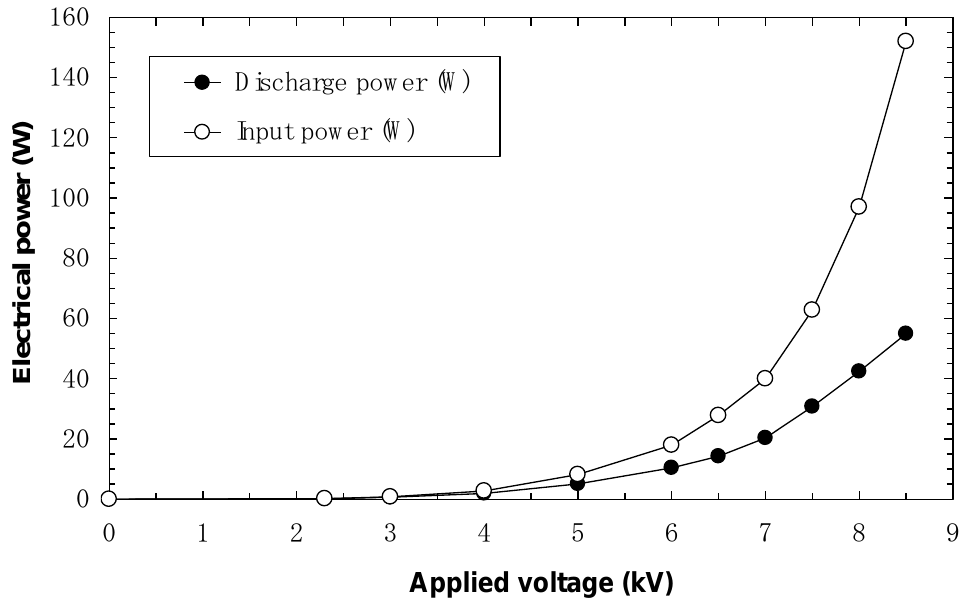
Figure 5. Electrical power vs. applied voltage for laminated film-electrode plasma reactor.